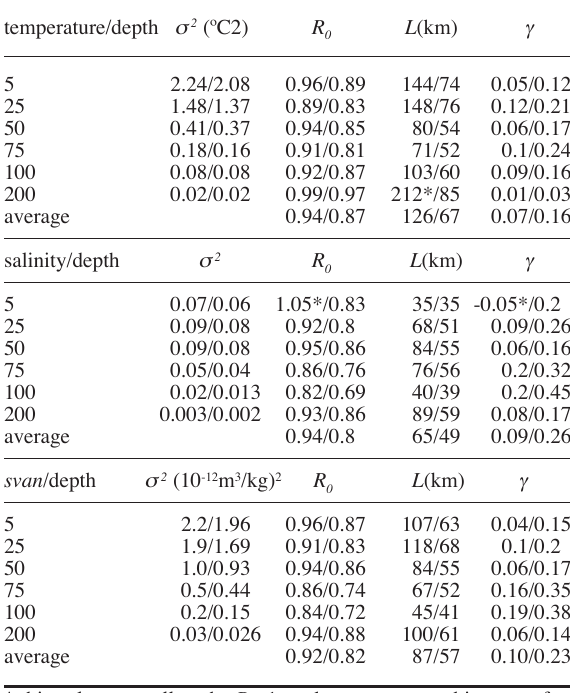
T ABLE 1. – Different parameters representing the covariance and correlation function for temperature, salinity and svan at different depths. In all the cases the first value is obtained by fitting an expo- nential function to the covariances or correlations represented ver- sus distance while the second value corresponds to the gaussian fit (see text, Section